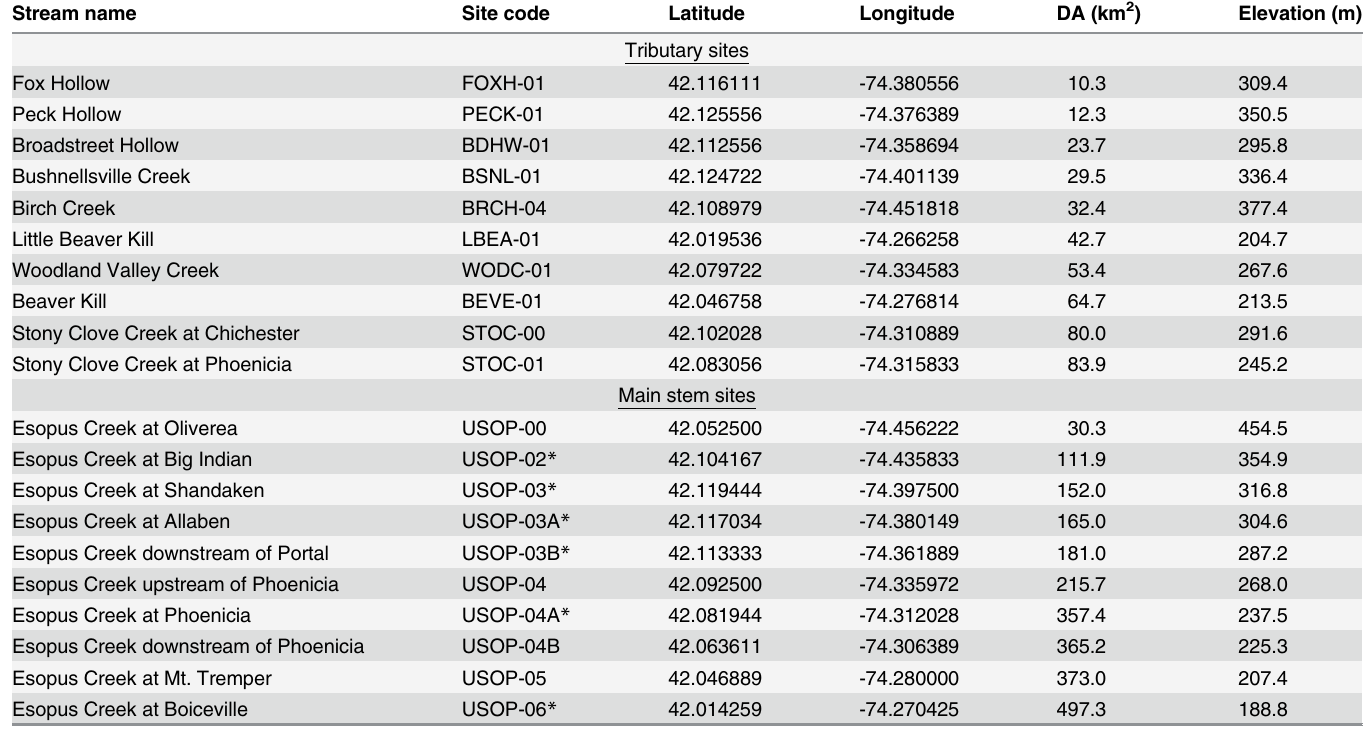
Table 1. Stream name, site code, coordinates, drainage area (DA), and elevation for periphyton surveys conducted on the Upper Esopus Creek and tributaries, 2009 – 2010. Asterisks denote seasonal sites that were sampled during all five